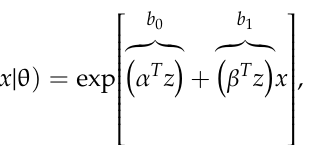
Table 2. Summary of capture-mark-recapture data sets describing badgers in one of two health states: “cub-positive” (badgers that tested positive in the first year of their lives) and “never-positive” (badgers that have never tested positive throughout their lives). Known birth years refers to cubs captured and identified as being within the first year of their lives. Known death years refers to badgers who were recovered dead and subjected to post-mortem. Detections are the total number of capture events that took place over the duration of the study. Summary Statistic